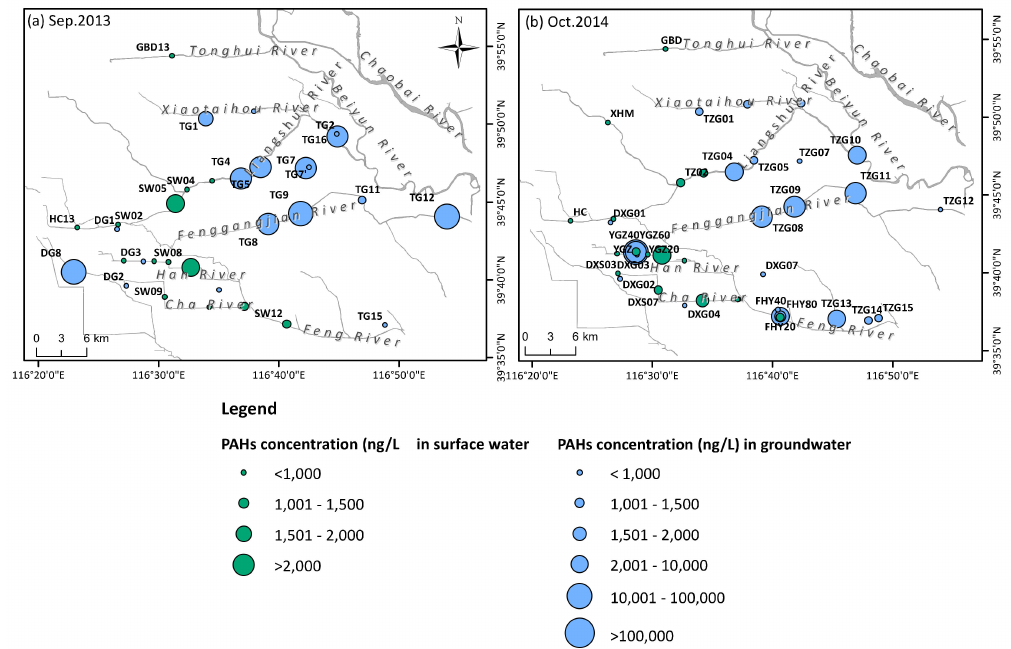
Figure 4. Spatial distribution of PAHs concentrations in surface water and groundwater during September 2013 ( a ) and October 2014 ( b